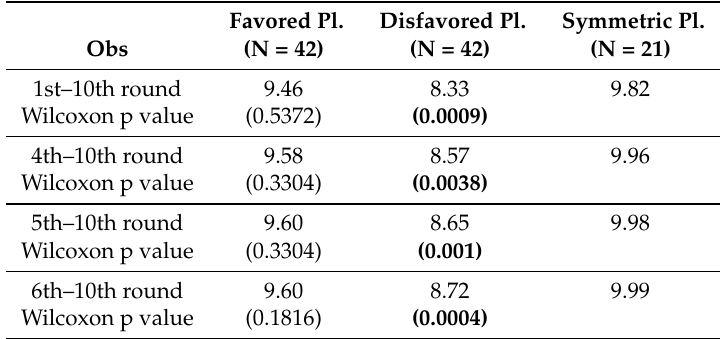
Table A2. Average Trade Proposals by Type of Player.